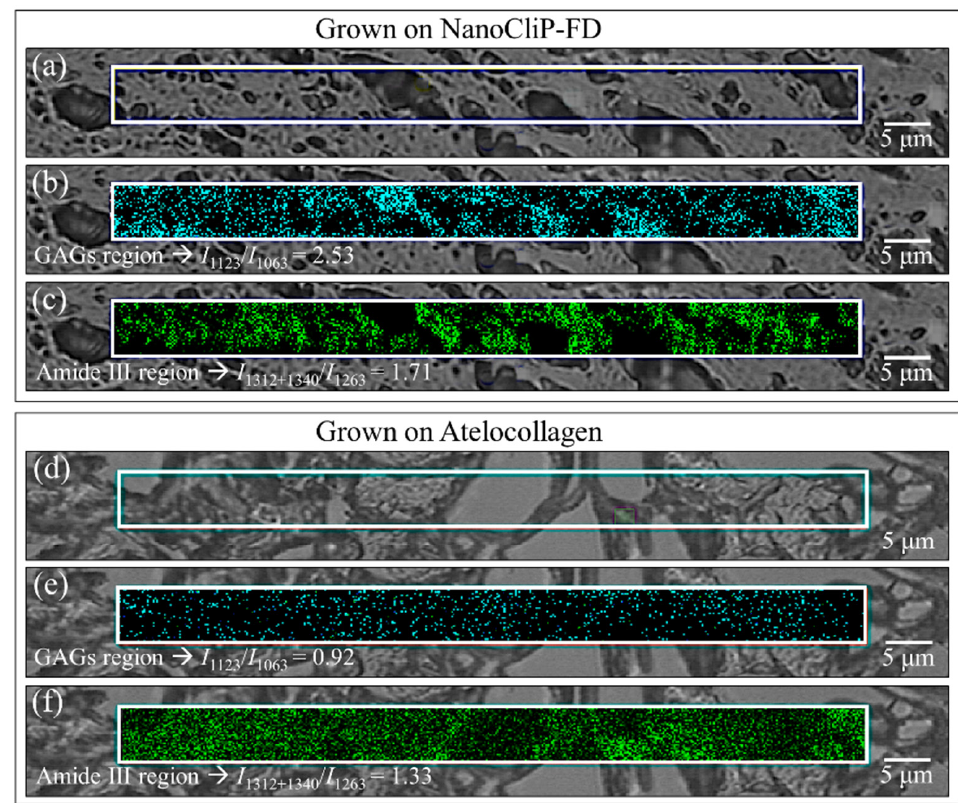
Figure 7. Raman maps collected on cartilage tissue grown onto NanoCliP-FD gel ( a , c ) and atelocollagen ( d – f ) scaffolds: ( a , d ) are optical micrographs, ( b , e ) represent the spatial distribution of the ratio I 1123 / I 1063 (measuring the fractional ratio of HA to CS), ( c , f ) show the spatial distribution of the ratio I 1312+1340 / I 1263 (measuring the degree of α -helix hydration).